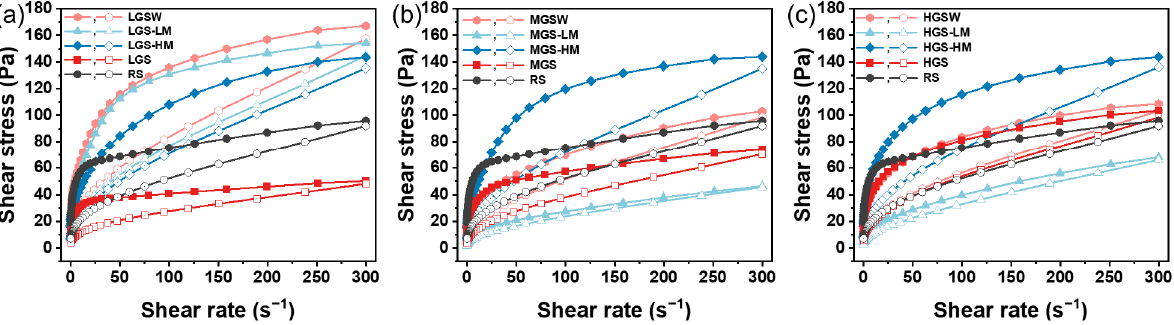
Figure 3. Static rheological curve of LGS ( a ), MGS ( b ), and HGS ( c ) reheated by different methods.